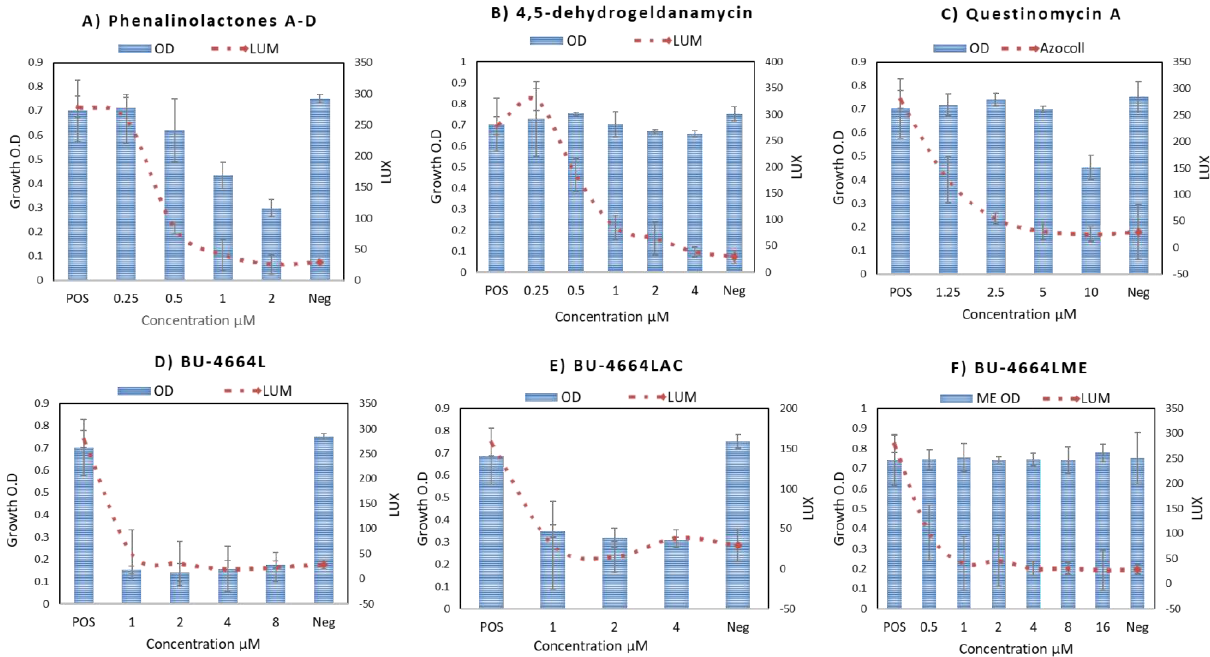
Figure 5. Effect of Phenalinolactones A–D, 4-5-dehydrogeldnamycin, Questinomycin A, BU–4664L,